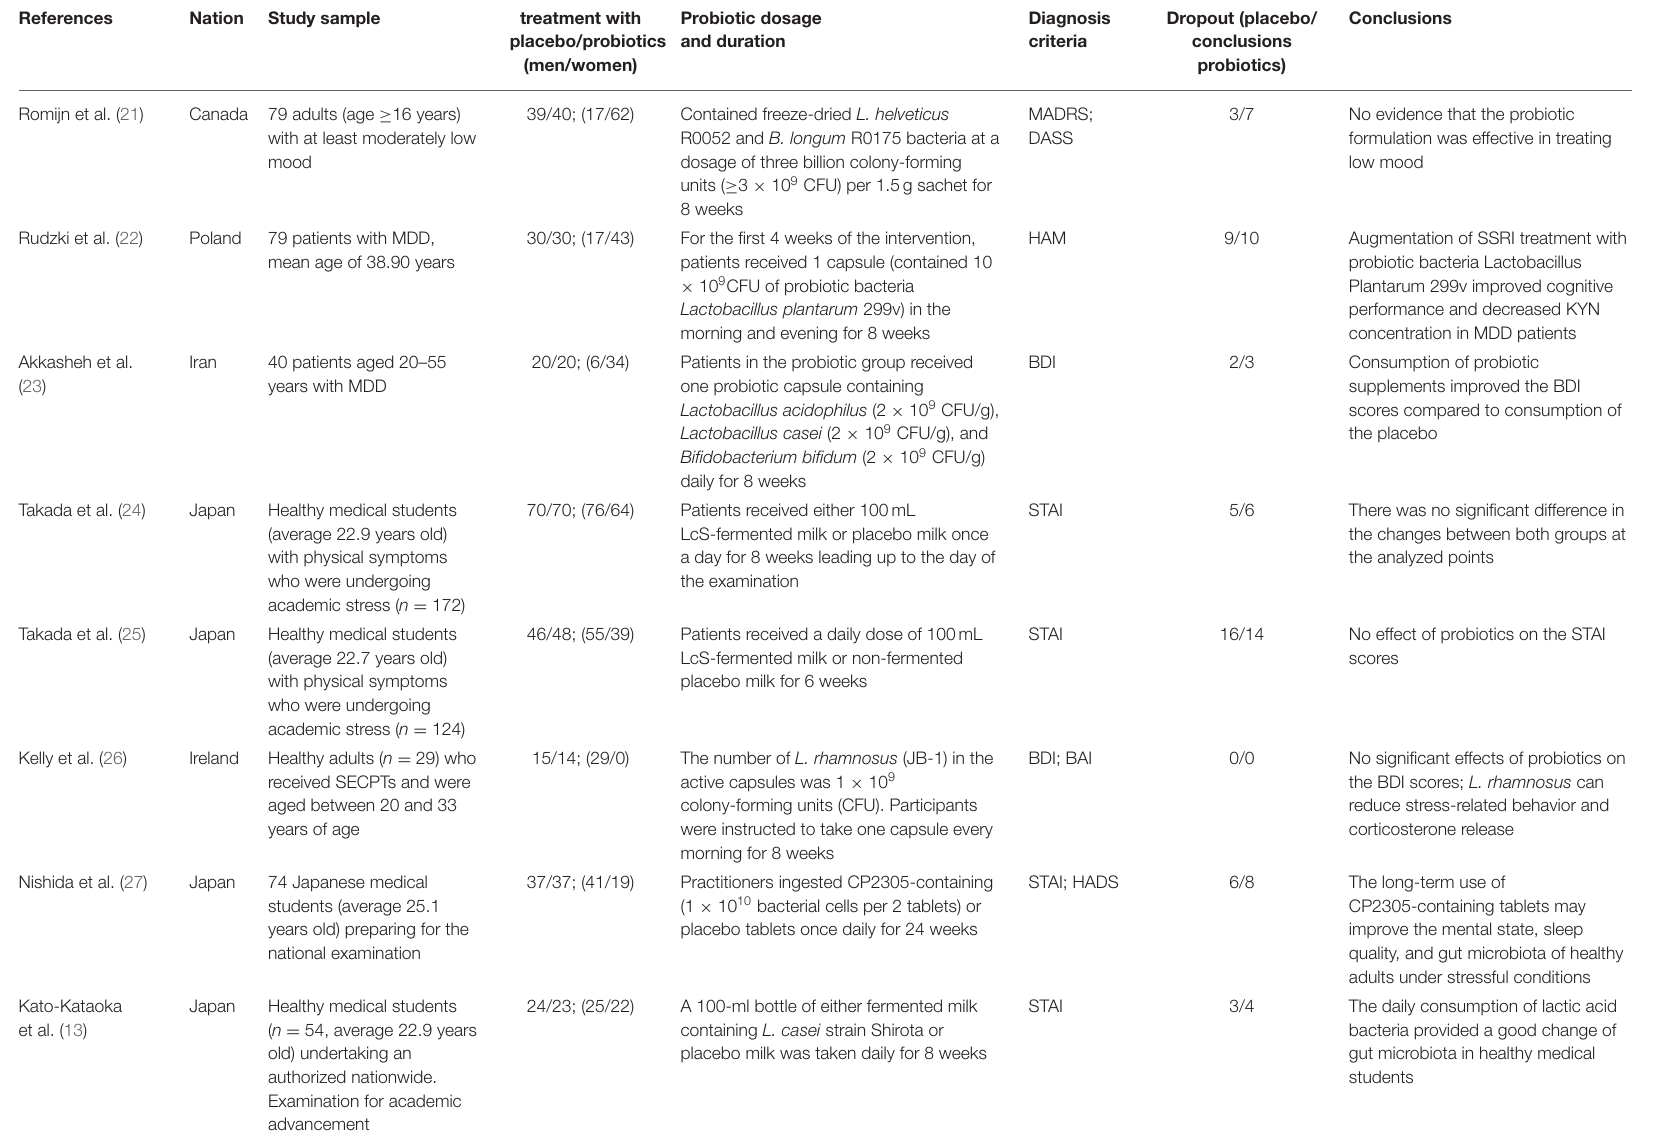
TABLE 1 | Main characteristics of the included